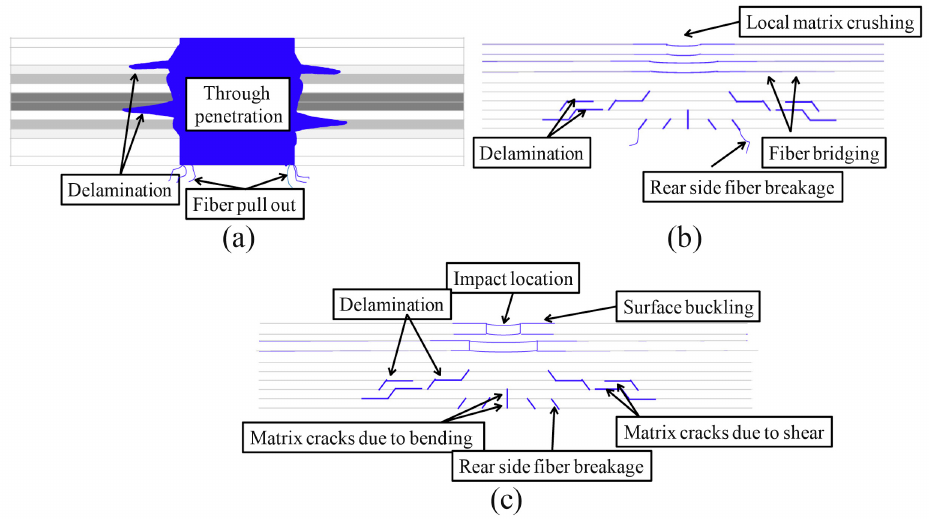
Figure 9. Deterioration mechanisms caused by impact loading ( a ) higher, ( b ) medium and ( c ) lower energy [65].